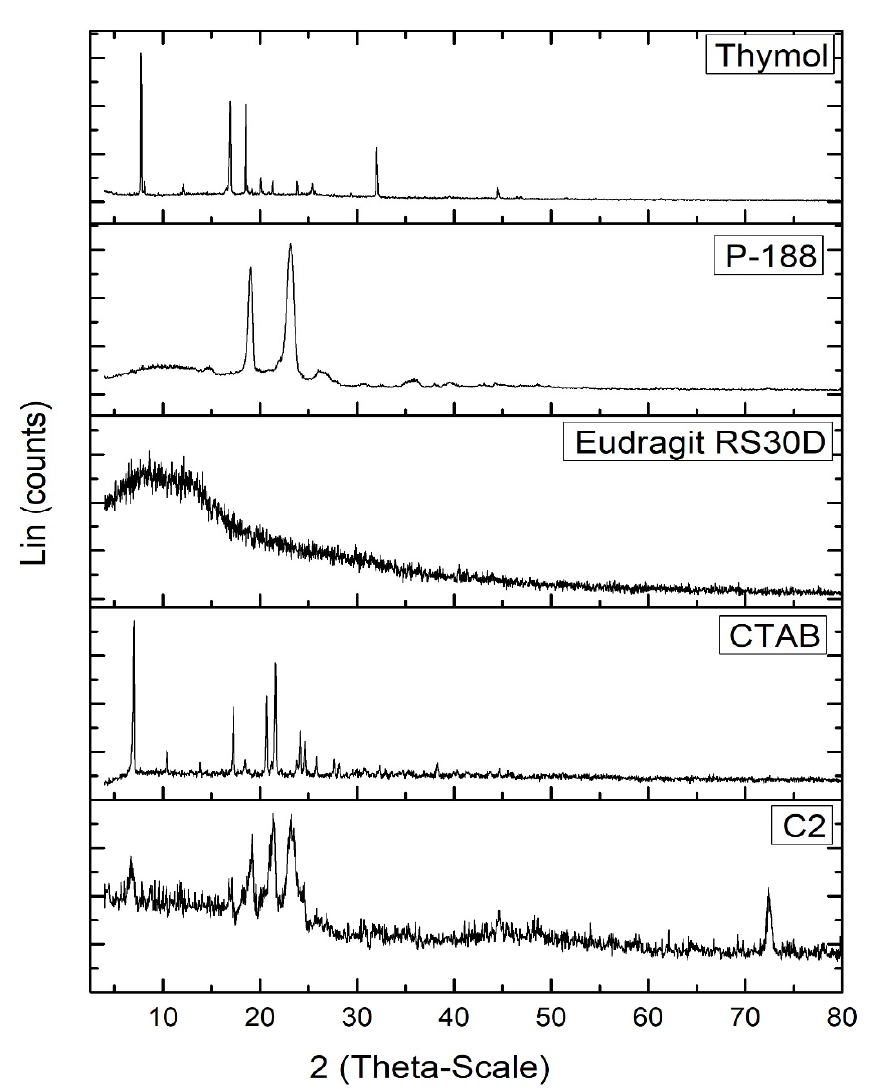
Figure 4. PXRD diffractograms of thymol, Eudragit RS30D, P-188, CTAB, and thymol-loaded CPNPs C2.